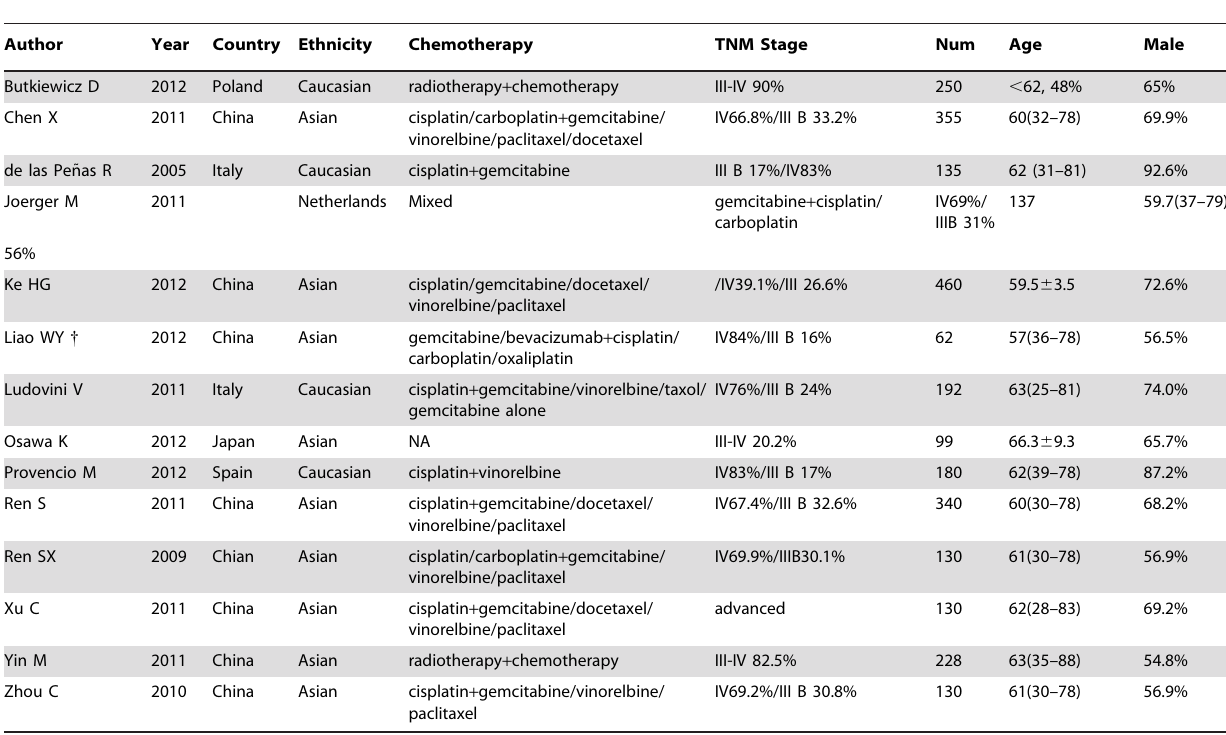
Table 1. Baseline Characteristics of Eligible